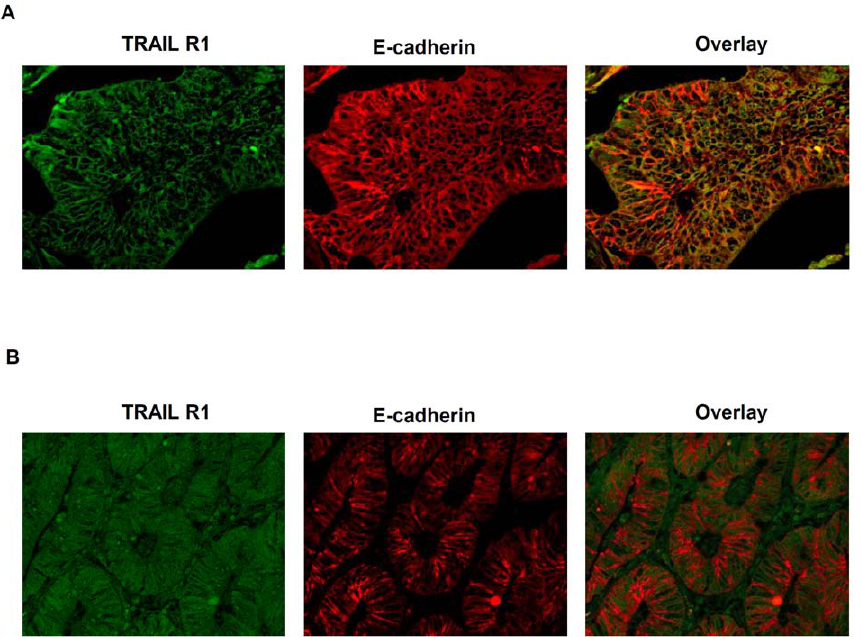
Figure 3. Membranous localization of TRAIL-receptors and E-cadherin. Representative pattern of co-staining of TRAIL-R1 and E-Cadherin on cell membranes of colorectal cancer cells by confocal microscopy showing (A) a pattern of predominant membrane staining vs. (B) non membranous staining. Staining for TRAIL-R1 (green, left panel), E-cadherin (red, middle panel) and overlays of these staining (right panel).